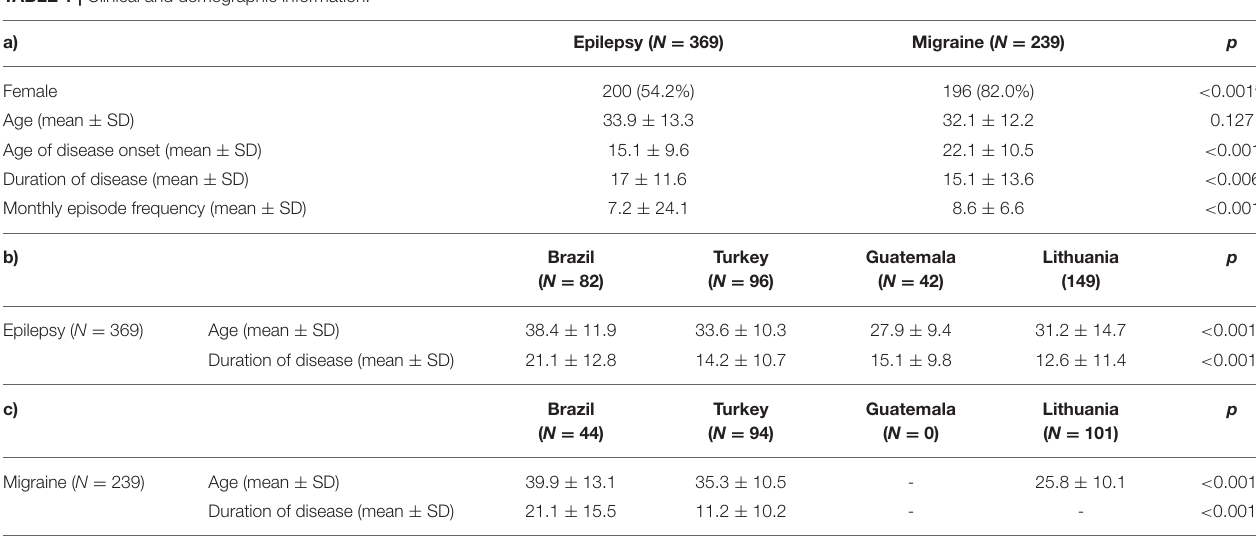
TABLE 1 | Clinical and demographic